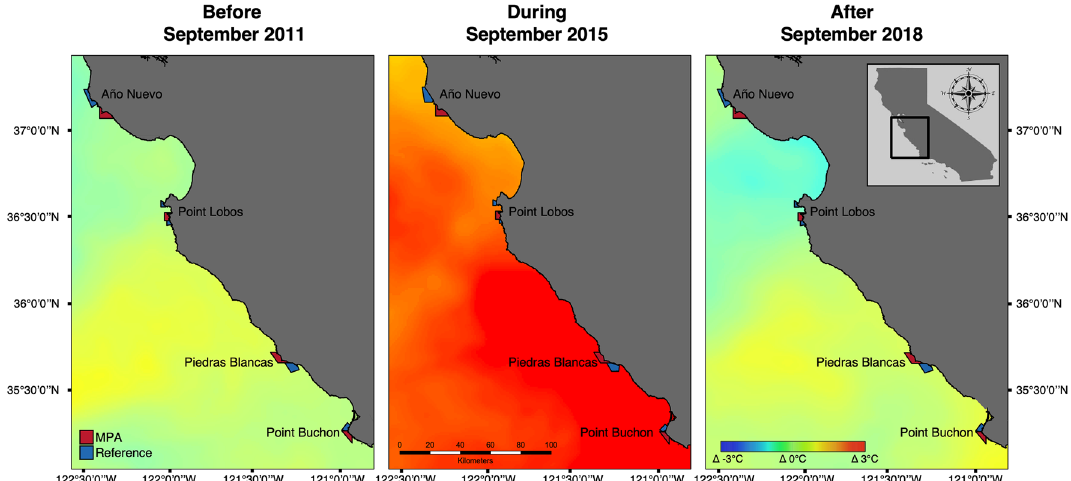
Figure 1. Maps of thermal anomalies in Central California in response to the marine heatwave (MHW). CCFRP MPA and reference sites overlaid with sea surface temperature anomalies for time periods before during and after the 2014–2016 MHW. All temperature anomalies were extracted as monthly means for the month of September three years prior to the heatwave (2011), during the heatwave (2015), and two years post-heatwave (2018). The years selected to represent the pre- and post-MHW were chosen due to presence of non-anomalous conditions during the summer months (MOCI = − 0.67 and 0.01, respectively). Data were extracted from the NOAA ERDDAP Multi-scale Ultra-high Resolution (MUR) SST Analysis Anomaly dataset (https:// coast watch. pfeg. noaa. gov/ erddap/ index. html) and maps were constructed in ArcMap (Version 10.8.1; https:// deskt op. arcgis. com/ en/ arcmap/). An extended version of this figure with all sampling years can be found in Fig. S1.